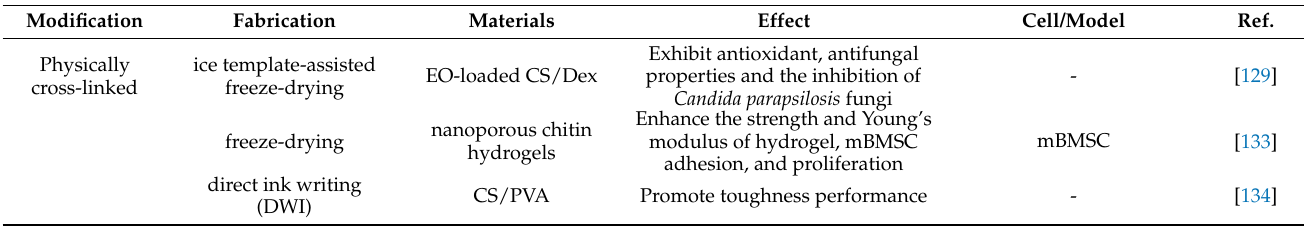
Table 1. Summary of the following different types of modifications of chitosan, fabrication techniques, bioactive molecules, and experimental model system in the study of bone regeneration in vitro and in